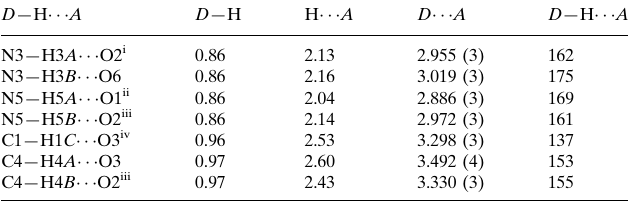
results in the formation of two-dimensional sheets parallel